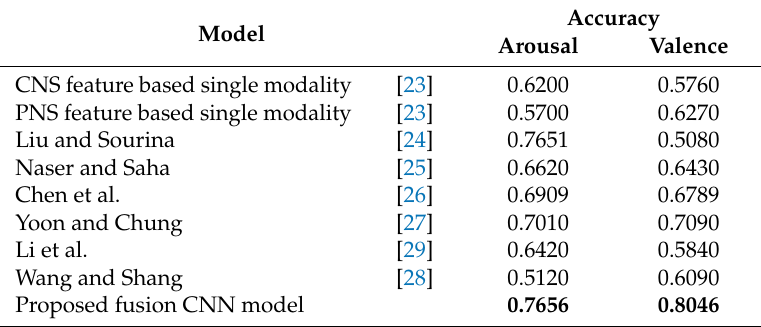
Table 5. Two class classification